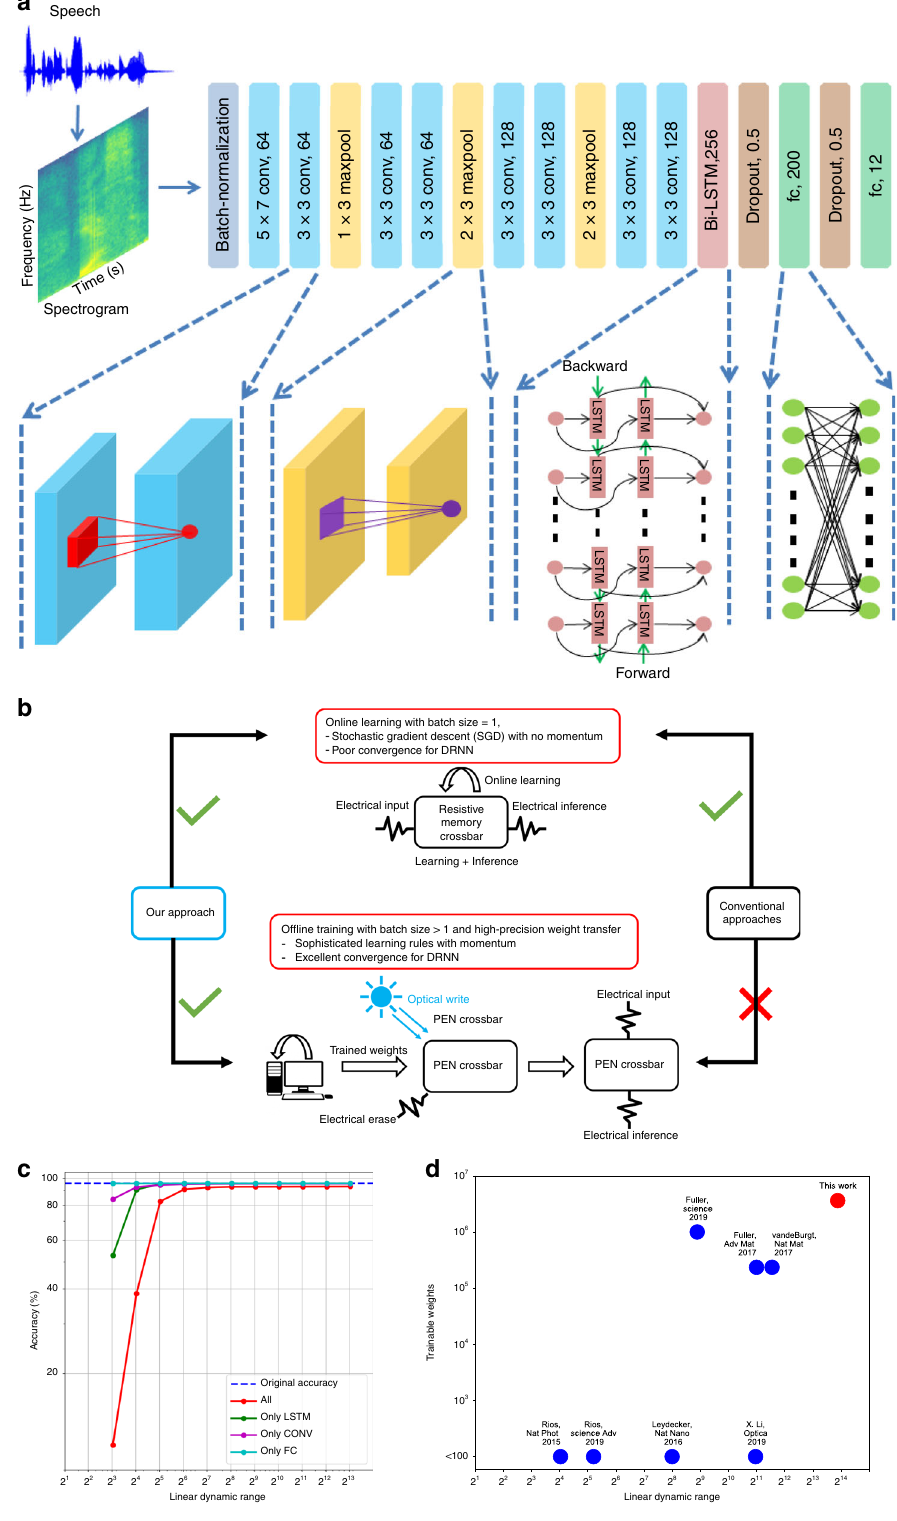
While noise sets the lower limit of achievable weight update, estimation errors limit the dynamic range of weight values accessible by our two-shot measurement scheme to ~600 (Supplementary Note 8, Supplementary Fig. 19). The number of